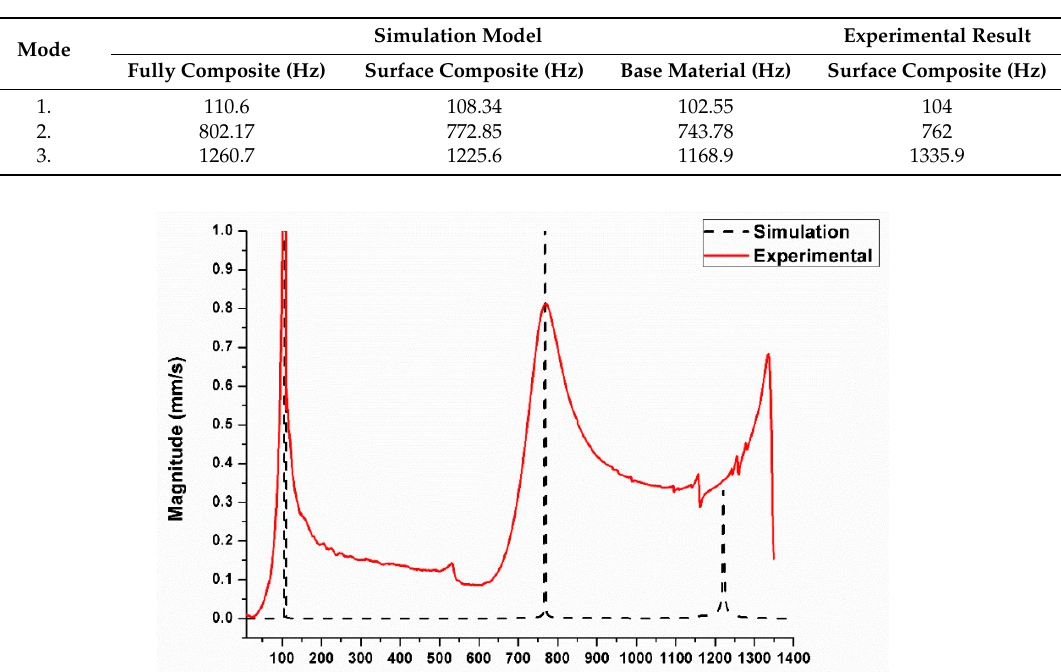
Table 1. Three mode shapes with corresponding fundamental frequencies in the simulation model and experimental test.